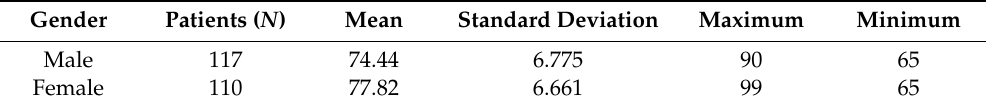
Table 1. Age-based standard deviation analysis.